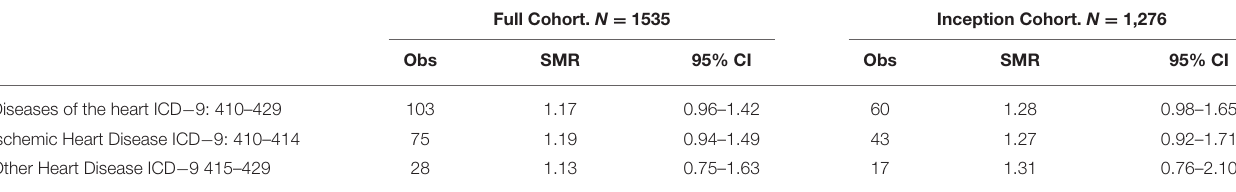
TABLE 4 | Cardiac mortality in German cohort: reference population: North Rhine–Westphalia.